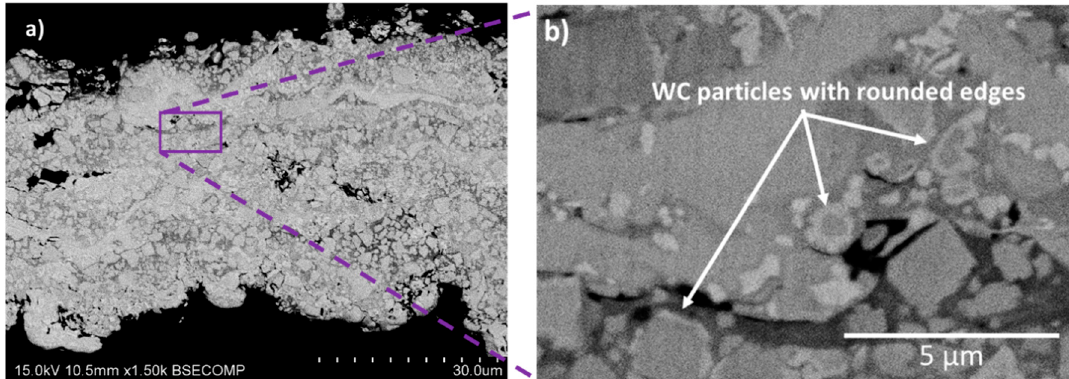
Figure 6. SEM micrographs in the cross-section of the two-layers WC-12Co coating: ( a ) general view and ( b ) details of the WC particles morphology in different coating zones.